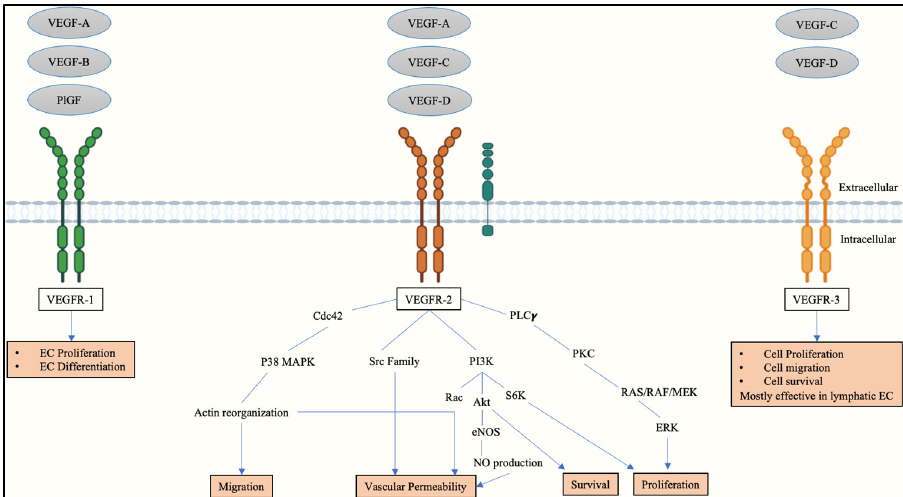
Figure 1. Schematic representation of the VEGF family and the signaling pathway of VEGFR-2. Abbreviations: vascular endothelial growth factor receptor-1 (VEGFR-1), vascular endothelial growth factor receptor-2 (VEGFR-2), vascular endothelial growth factor receptor-3 (VEGFR-3), vascular endothelial growth factor-A (VEGF-A), vascular endothelial growth factor-B (VEGF-B), vascular endothelial growth factor-C (VEGF-C), vascular endothelial growth factor-D (VEGF-D), placental growth factor (PlGF), neuropilin-1 (NRP-1), endothelial cell (EC), Mitogen-activated protein kinase (MAPK), phospholipase-C γ (PLC γ ), Src (proto-oncogene tyrosine-protein kinase sarcoma), protein kinase C (PKC), Rat sarcoma virus (RAS), Rapidly Accelerated Fibrosarcoma (RAF), Extracellular- signal-regulated kinase (ERK), Phosphoinositide-3 kinase (PI3K), Ribosomal protein S6 kinase (S6K), protein kinase B (Akt), endothelial nitric oxide synthase (eNOS), nitric oxide (NO).